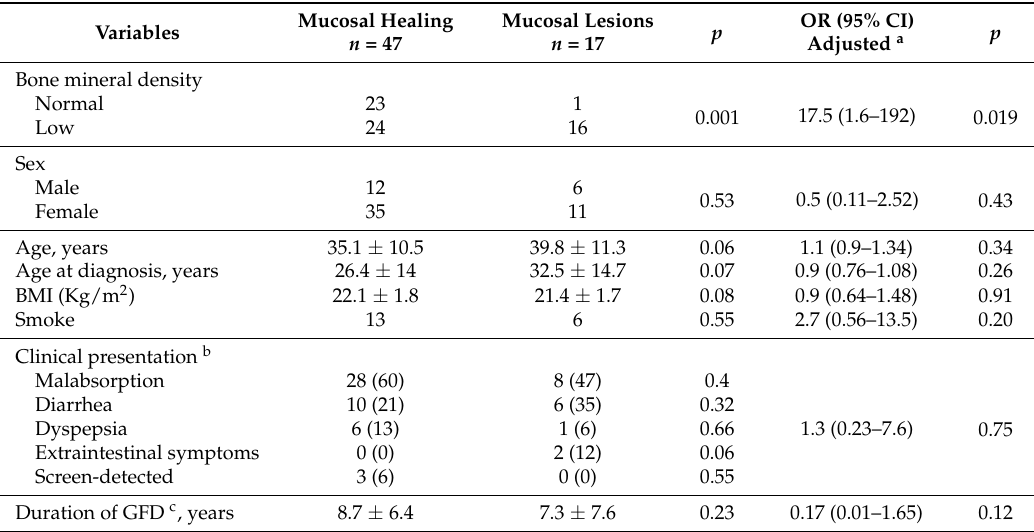
Table 3. Characteristics of the 64 patients with celiac disease on a gluten-free diet according to duodenal mucosa healing as assessed by Marsh